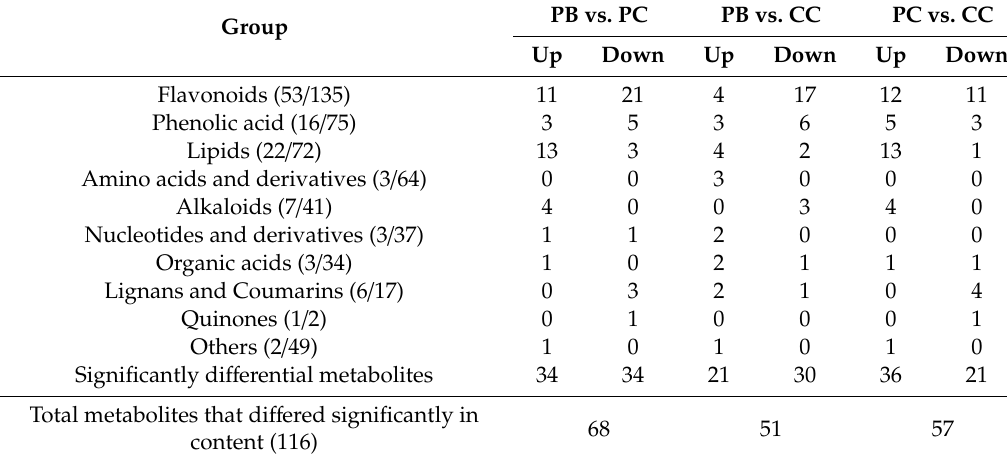
Figure 4. Venn diagram illustrating shared or unique metabolites that differed significantly in terms of content among the different comparison. Table 2. The number of metabolites that had significantly different contents in D. officinale cultured in PB, PC, and CC.